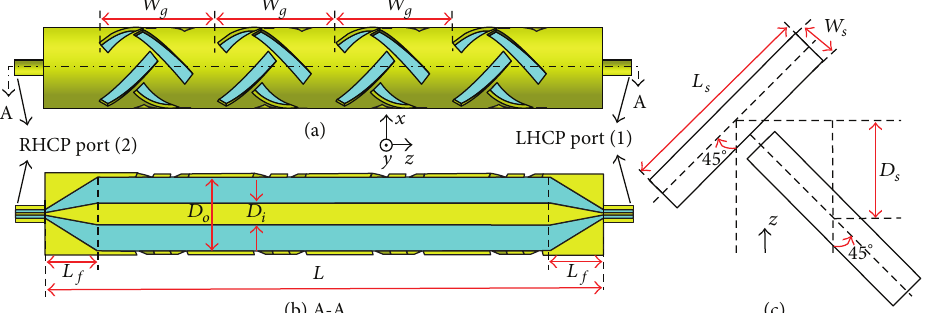
Figure 1: Geometry of the omnidirectional dual circularly polarized (CP) antenna. (a) Side view. (b) A-A section view. (c) Geometry of the slot pairs.